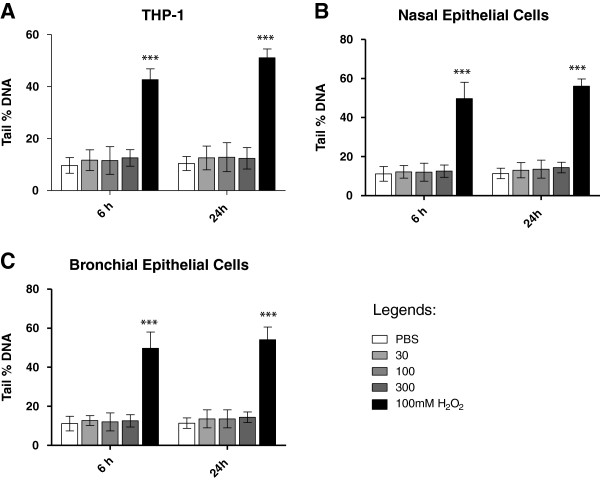
Percentage DNA damage studied using comet assay in all three cell types. Percent of DNA in the tail (tail DNA%) was used as a marker of DNA damage in all three cell types (A) THP-1 cell line, (B) nasal epithelial cells and (C) small airway epithelial cells. All values are depicted as mean± SE.